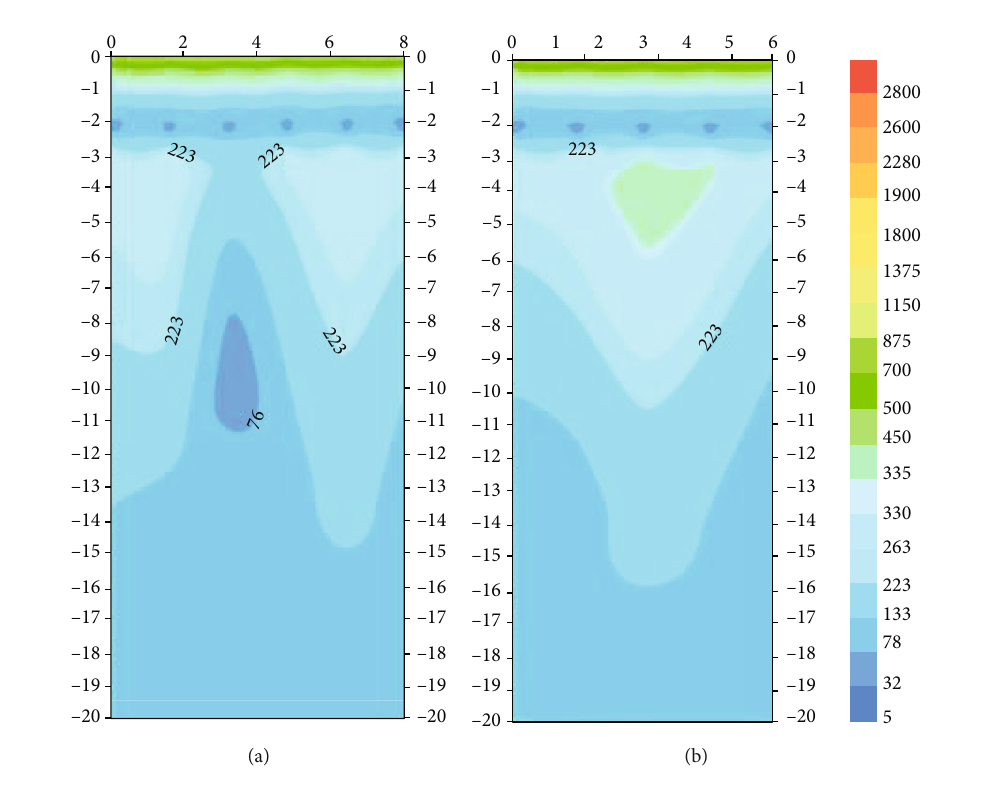
Figure 11: Resistivity isoline: (a) line 1 and (b) line